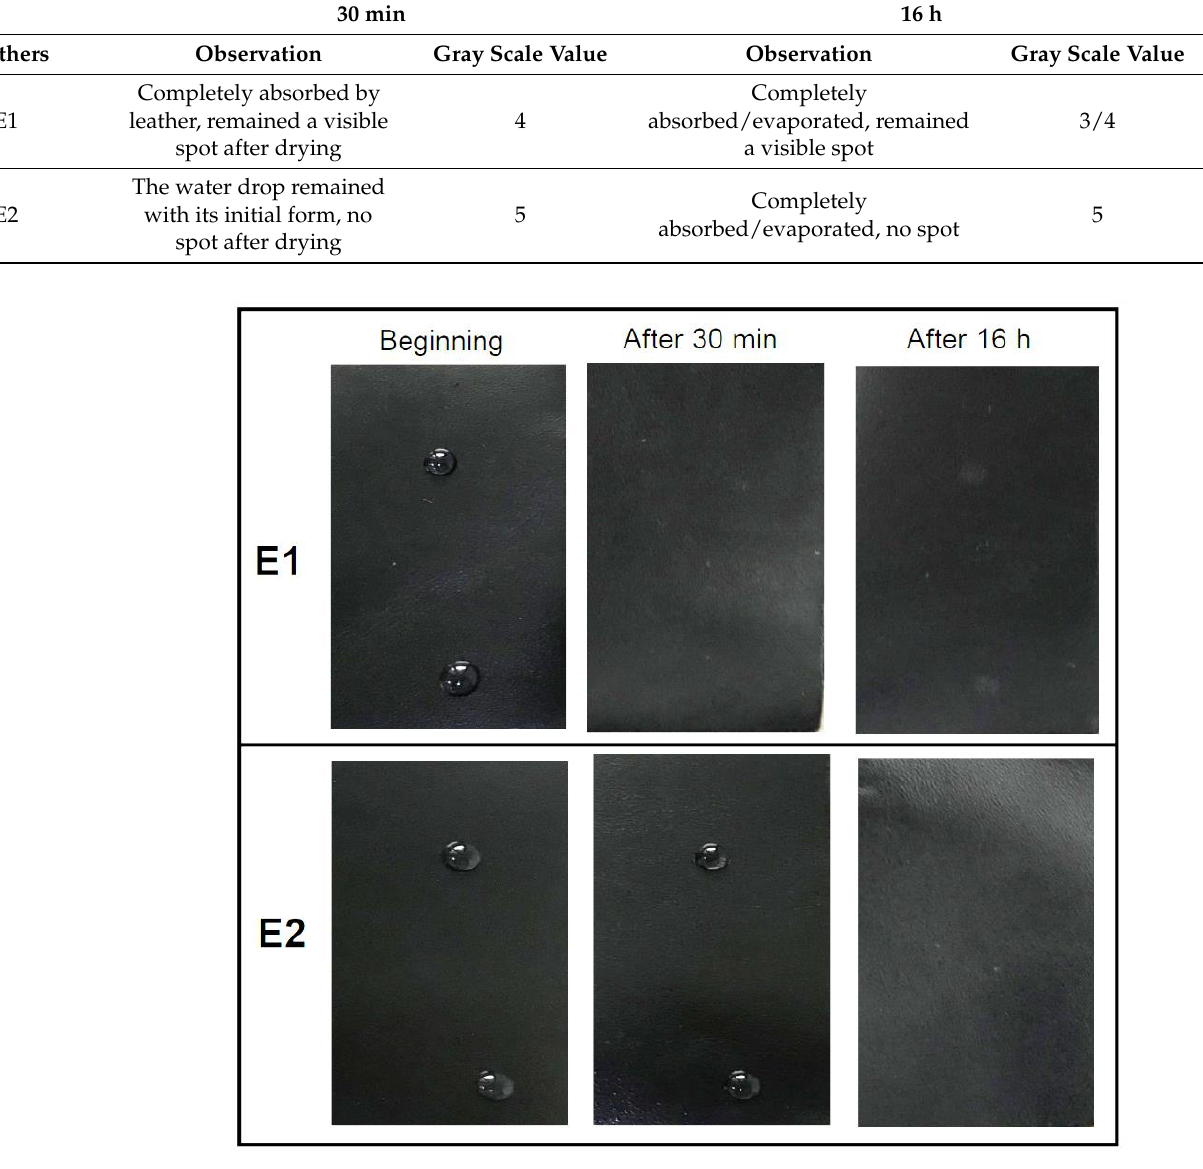
Figure 8. The images taken at the beginning of, 30 min and 16 h after placing the water drops on the leather surface.